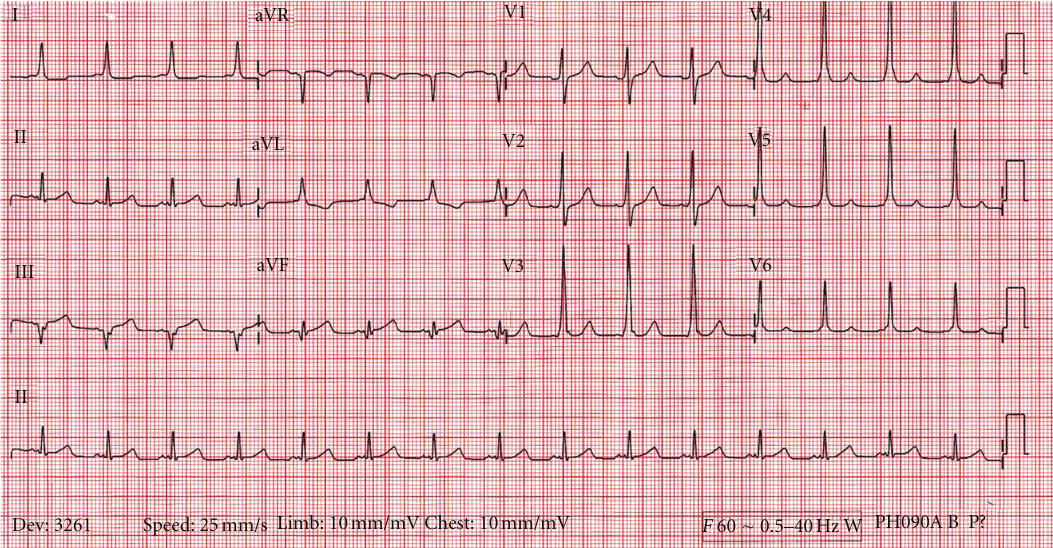
Figure 2: EKG showing sinus rhythm with underlying Wol ff -Parkinson-White disease and classic upsloping QRS seen best in leads V3, V4, and